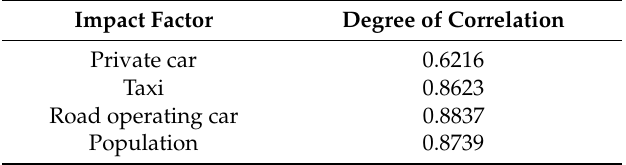
Table 2. Influence degree of each impact factor on tra ffi c accident.